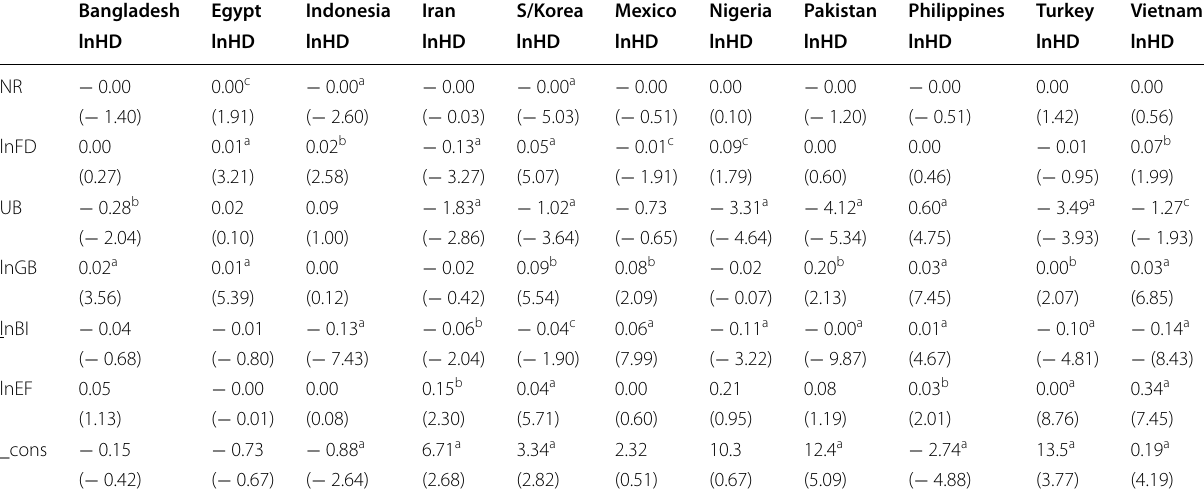
t statistics in parentheses;